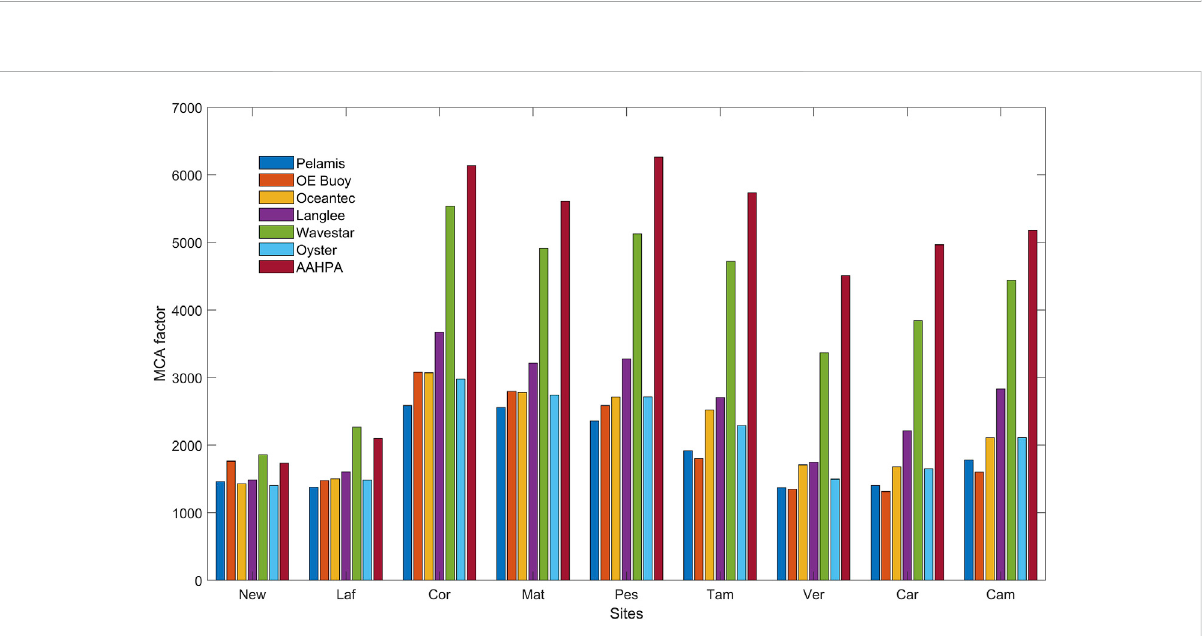
FIGURE 13 Multi-Criteria-Approach factor of different WECs for the 9